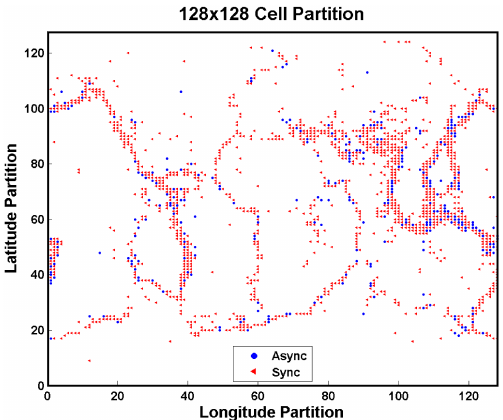
Figure 12. Chimera-state map of the synchronous and asyn- chronous oscillators as a steady-state solution for a non-recurrence case. The non-local coupling coefficient parameter, κ , is 0.1. Blue dots refer to the asynchronous oscillators and red dots to the syn- chronous